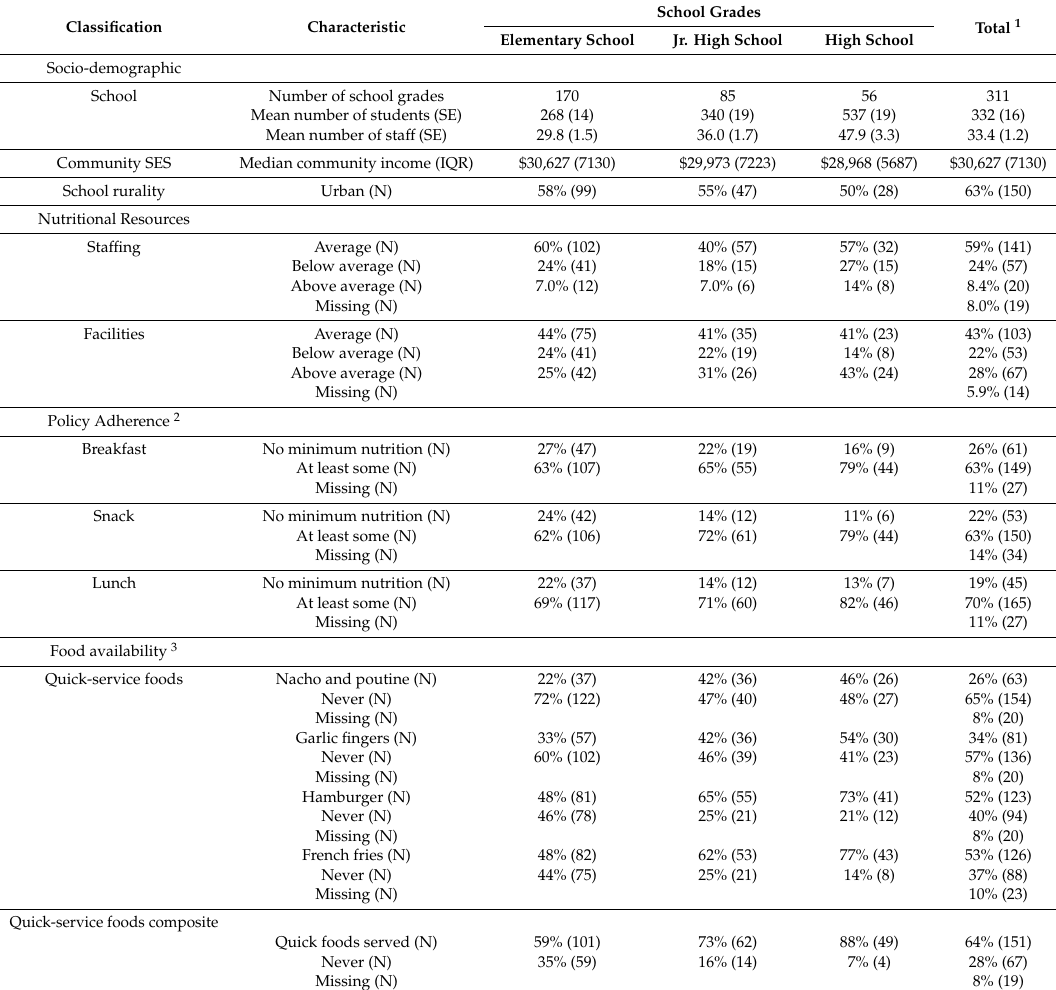
Table 1. School characteristics for analytical samples by grades within each school, N = 237 1